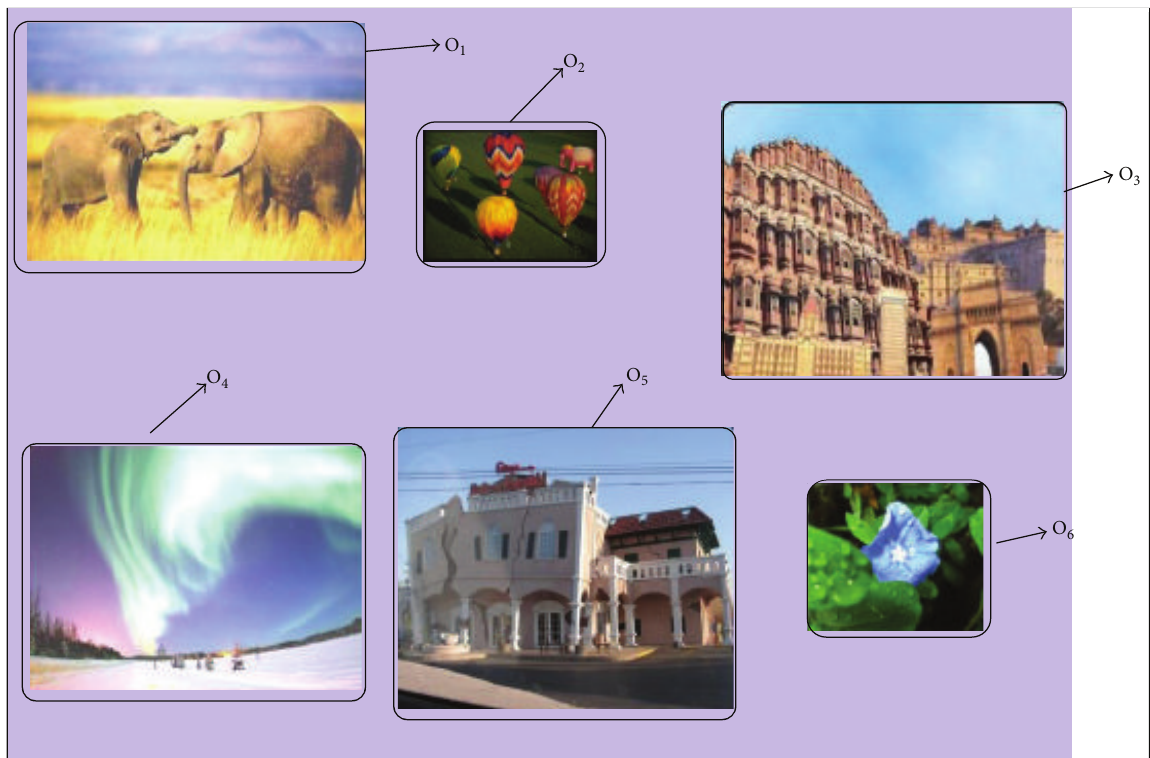
Figure 10: An example page used in the